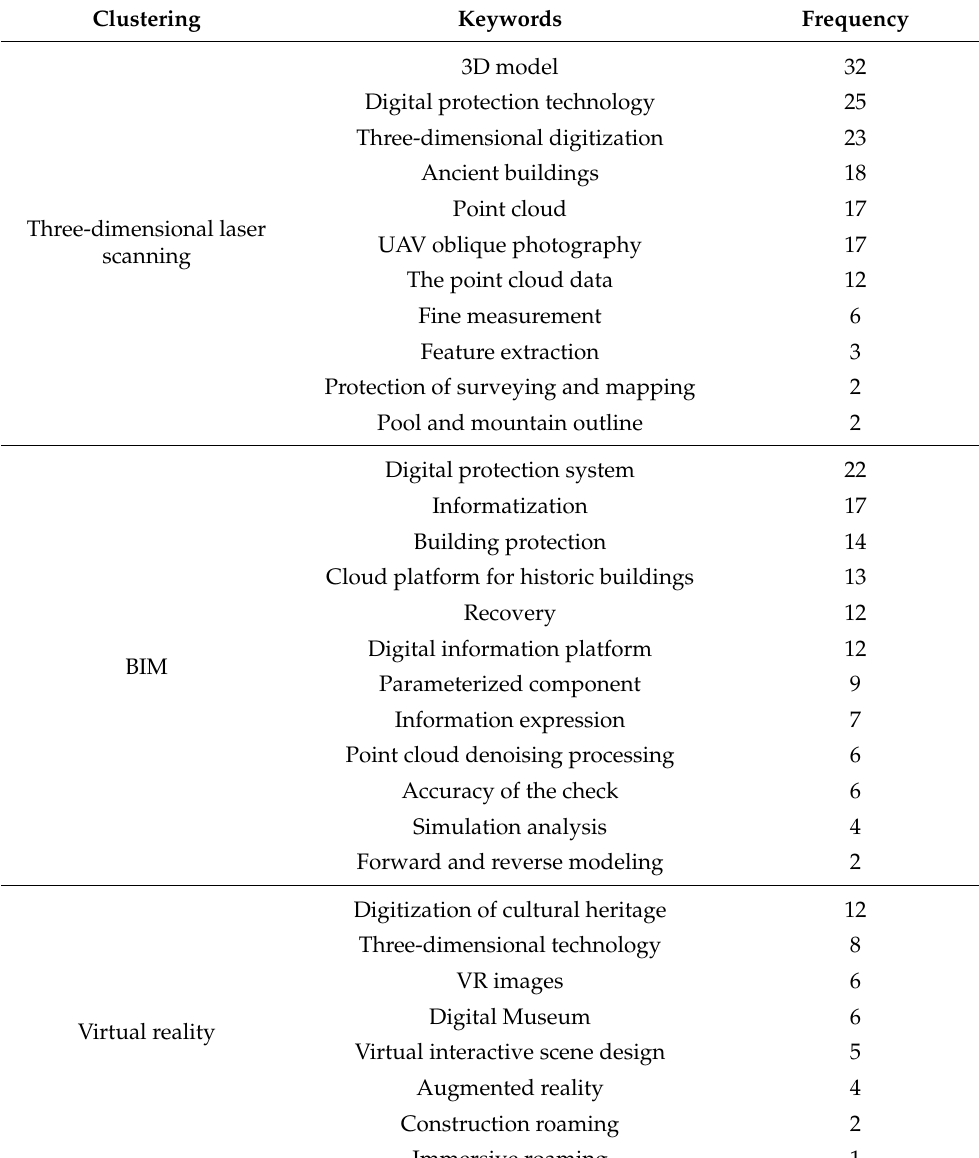
Table 1. The frequency of digital technology clustering information of landscape architecture heritage